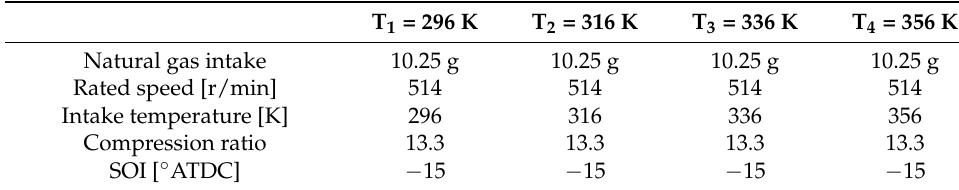
Table 5. The simulation